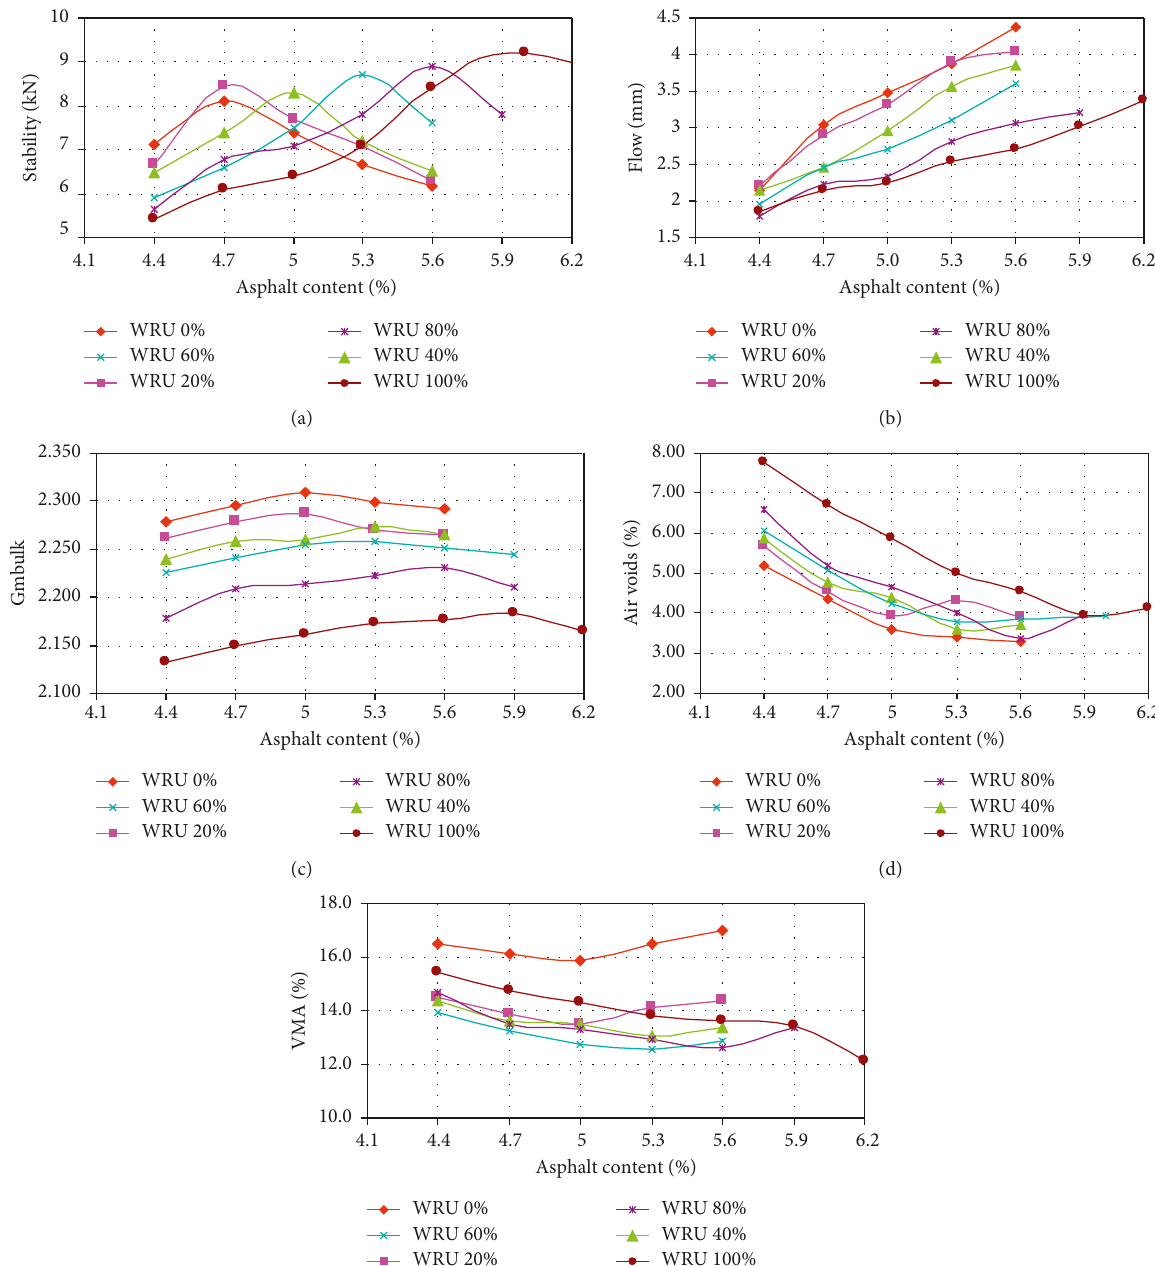
Figure 7: Marshall properties for WRU